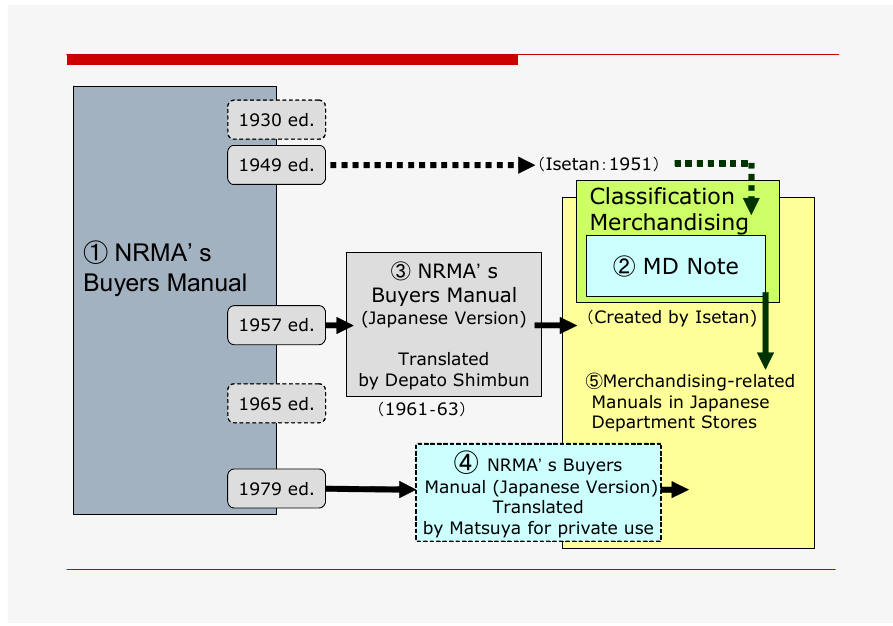
Figure 3. Flow of MD knowledge transfers from U.S. to